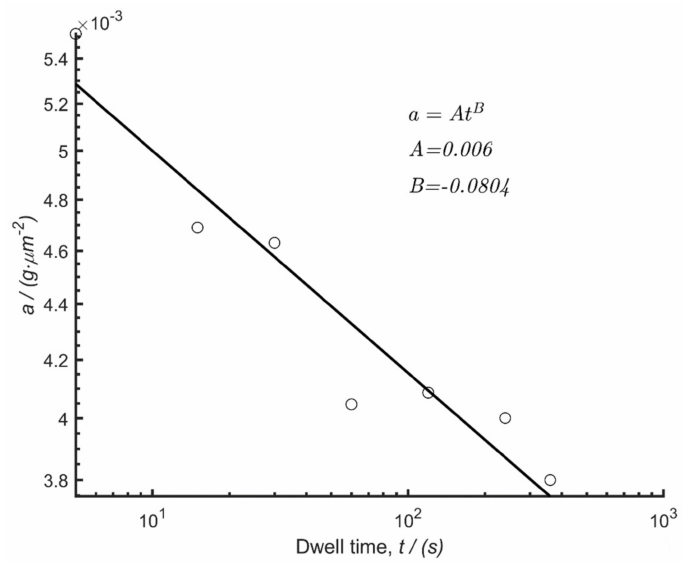
Figure 8. Relationship between parameter a and dwell time with a regression fit to get parameters A and B .